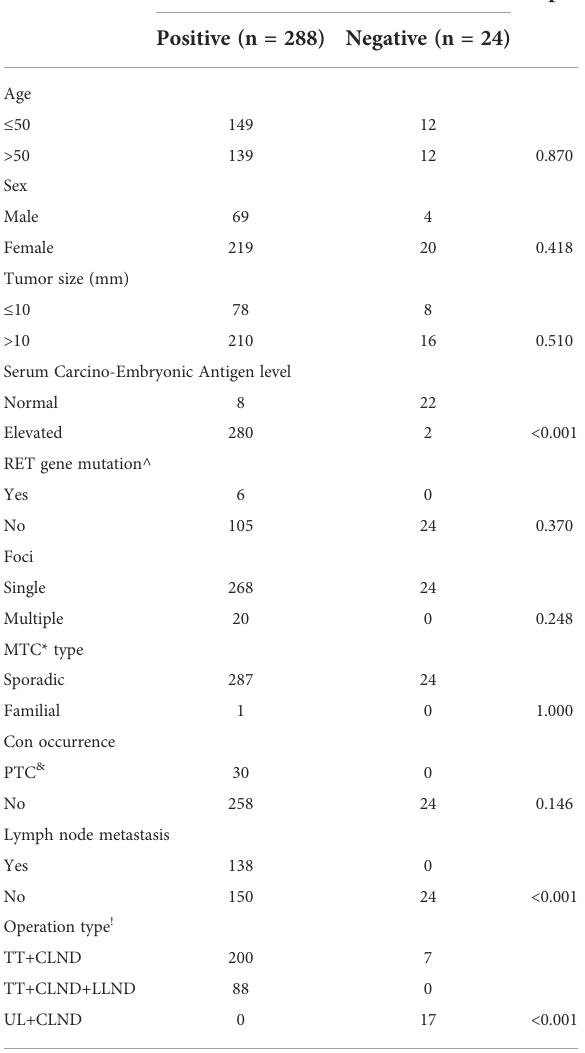
TABLE 1 Comparison of clinicopathologic variables between negative and positive groups. Variable